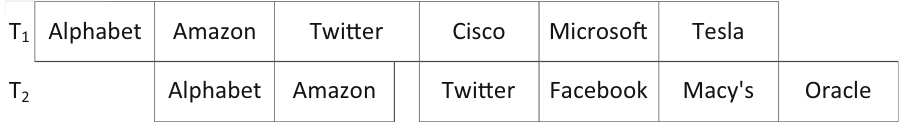
Fig. 2 A delay in transaction